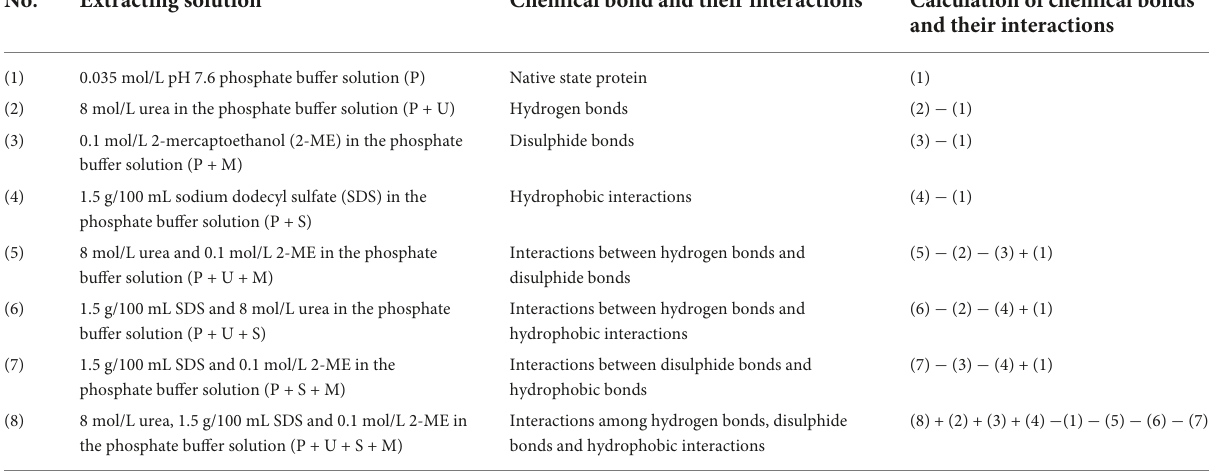
TABLE 1 Information about the extracting solutions, and calculation of chemical bonds and their interactions. No. Extracting solution Chemical bond and their interactions Calculation of chemical bonds